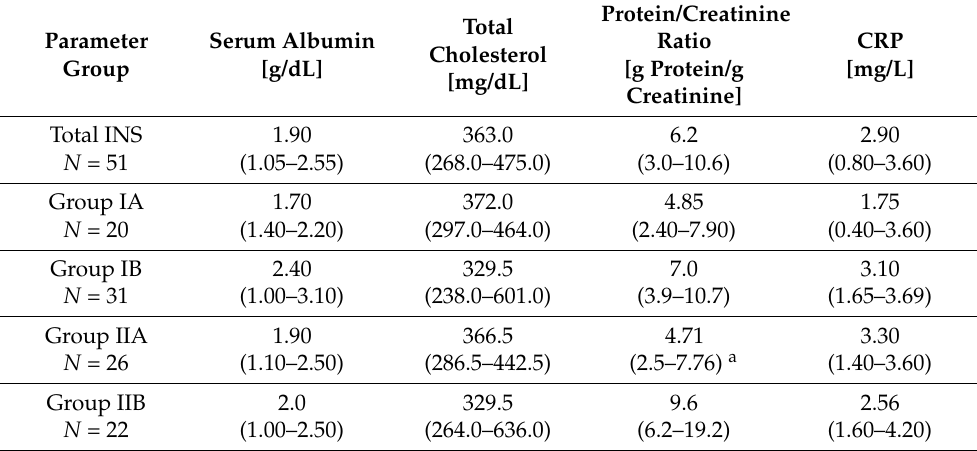
Table 1. Selected biochemical parameters in all children with INS and in examined subgroups according to the number of relapses and treatment modality. Data are presented as median values and interquartile ranges.